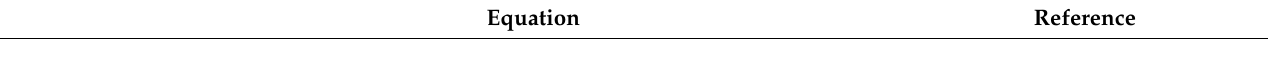
Table 1. Summary of raw bands and vegetation